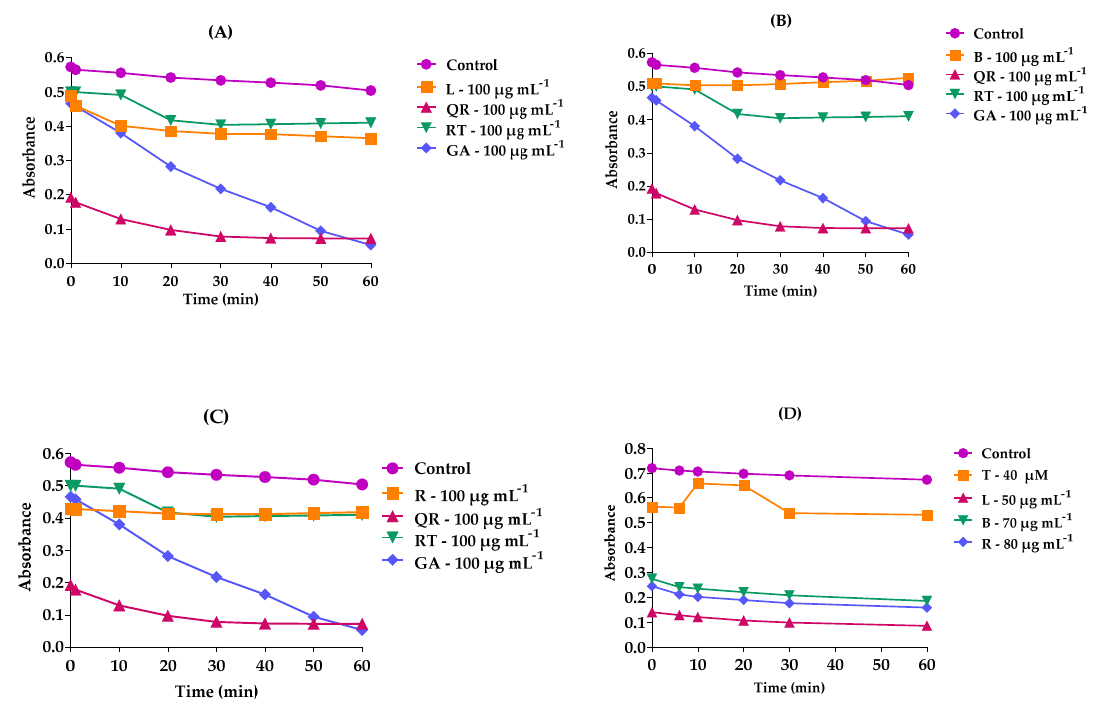
Figure 2. Kinetic curve of the antioxidant capacity of M. hirsuta from ( A ) DPPH—methanol extract of leaves, ( B ) DPPH—methanol extract of branches, ( C ) DPPH—methanol extract of roots, compared to rutin, quercetin, gallic acid as standards, and (Control—no antioxidant). ( D ) ABTS—methanol extracts of leaves, branches and roots compared to TROLOX (40 µ M) and control (without antioxidant). L—Leaves, B—Branches, R—Roots; positive controls: RT: rutin, QT: quercetin and GA: gallic acid.